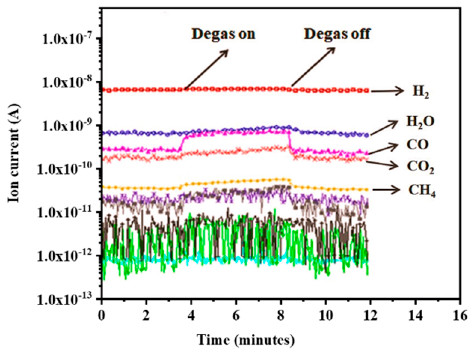
Figure 8. Residual gas composition of UHV chamber background after 24 h degassing, corresponding to a total pressure of 3 × 10 –6 Pa.